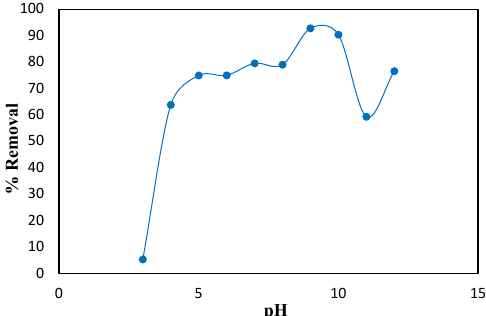
Fig. 2. Effect of pH for the percentage removal of iron (III) ions by CuO NPs.